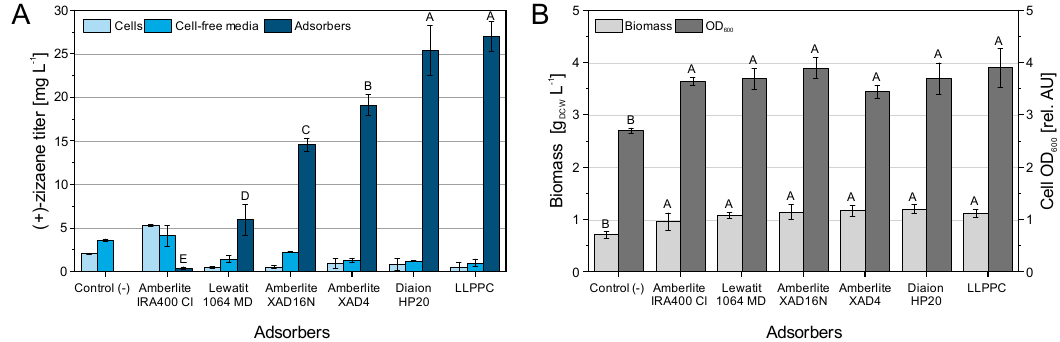
Figure 4. Screening of distinct polymeric adsorbers for the recovery of (+)-zizaene. ( A ) (+)-zizaene titers recovered from cells, cell-free media, and adsorbers. ( B ) Cell growth expressed by biomass and cell optical density. The negative control corresponds to culture without extractants. Data are the mean of three replicates with error bars as SD. Variables analyzed by ANOVA ( α = 0.05), letters that differ are significantly different.